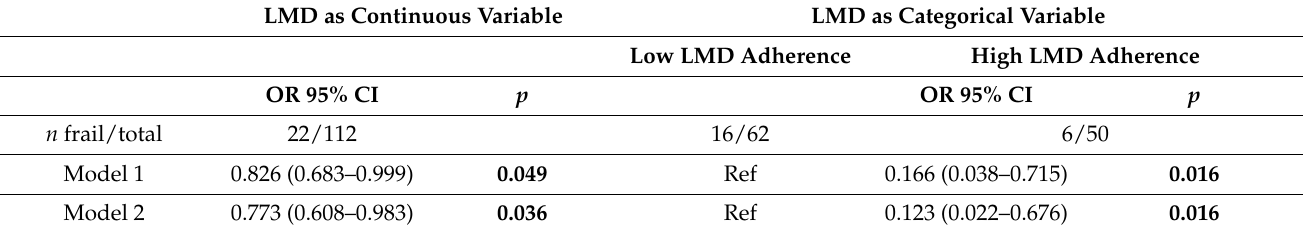
Table 4. Association between LMD adherence and the modified frailty index among Lebanese community-dwelling older